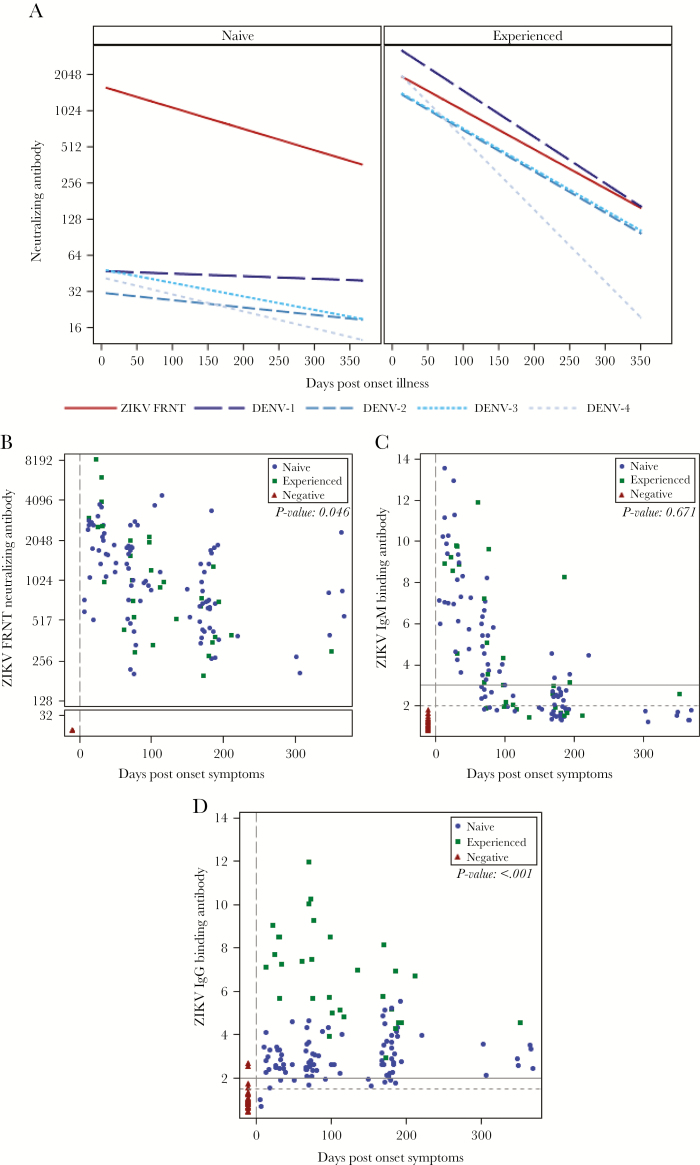
Serum-neutralizing antibody, immunoglobulin M (IgM), and IgG titers against Zika virus (ZIKV) and/or dengue virus (DENV) 1–4 over time in DENV-naïve patients, DENV-experienced patients, or controls. A, Best fit curves for focus reduction neutralization test (FRNT)50 titers against ZIKV and DENV1–4. The 45 patients with ZIKV infection were categorized as DENV-naïve (left panel) or DENV-experienced (right panel). Supplementary Table 4 provides the full antibody results for each time point for each subject and categorizes DENV-experienced vs -naïve cases and controls. B, All NAb time points for cases (DENV-experienced, green; DENV-naïve, blue) and controls (red). ZIKV-specific NAb titers (FRNT50) for all cases persisted with a half-life of 105 days. NAb titers were higher for DENV-experienced cases (P = .046), particularly early cases (ie, through day ~50). C, ZIKV cases anti-ZIKV IgM Ab levels were highest at the earliest time points available and decreased over time to negative (or equivocal) levels. IgM against ZIKV was not detected in controls. Solid horizontal line, positive cutoff (≥3); dashed horizontal line, equivocal cutoff (2–2.99). No significant difference in IgM levels was observed between DENV-experienced and -naïve patients (P = .671). D, Anti-ZIKV IgG levels were significantly higher in DENV-experienced patients relative to DENV-naïve (P < .001). Solid horizontal line, positive cutoff (≥2); dashed horizontal line, equivocal cutoff (1–1.99). One control had 2 low-level positive anti-ZIKV IgG values (control subject ZZ155 in Supplementary Table 4), likely due to cross-reactive IgG induced by a remote DENV infection. That subject also had low-level anti-DENV NAb as well.